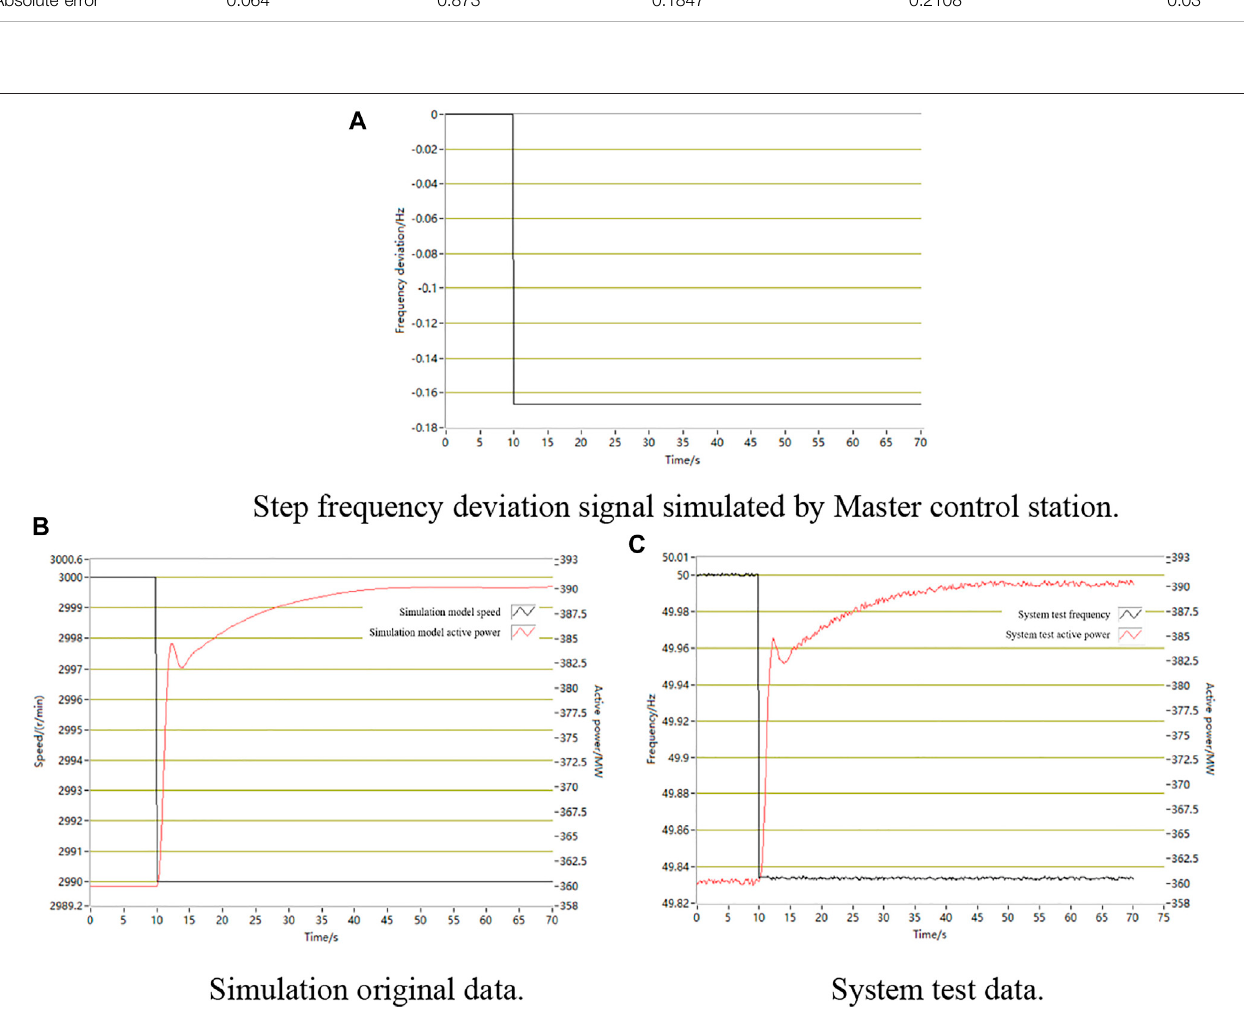
FIGURE 13 | Step signal simulation